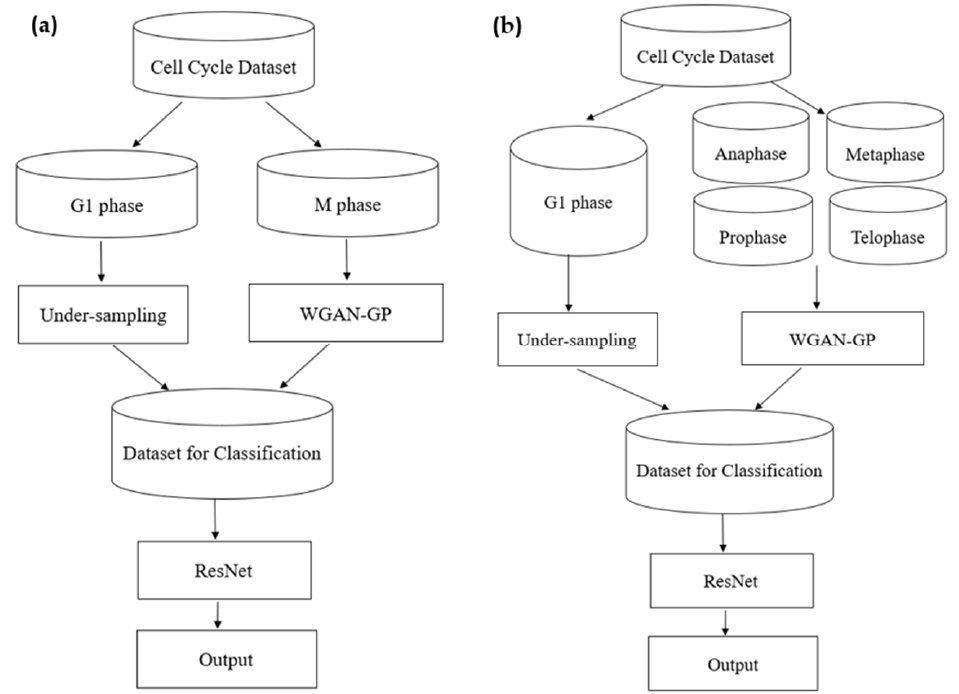
Figure 1. Overview of the framework for our model. ( a ) The framework of four stages of classification; ( b ) the framework of seven stages of classification.